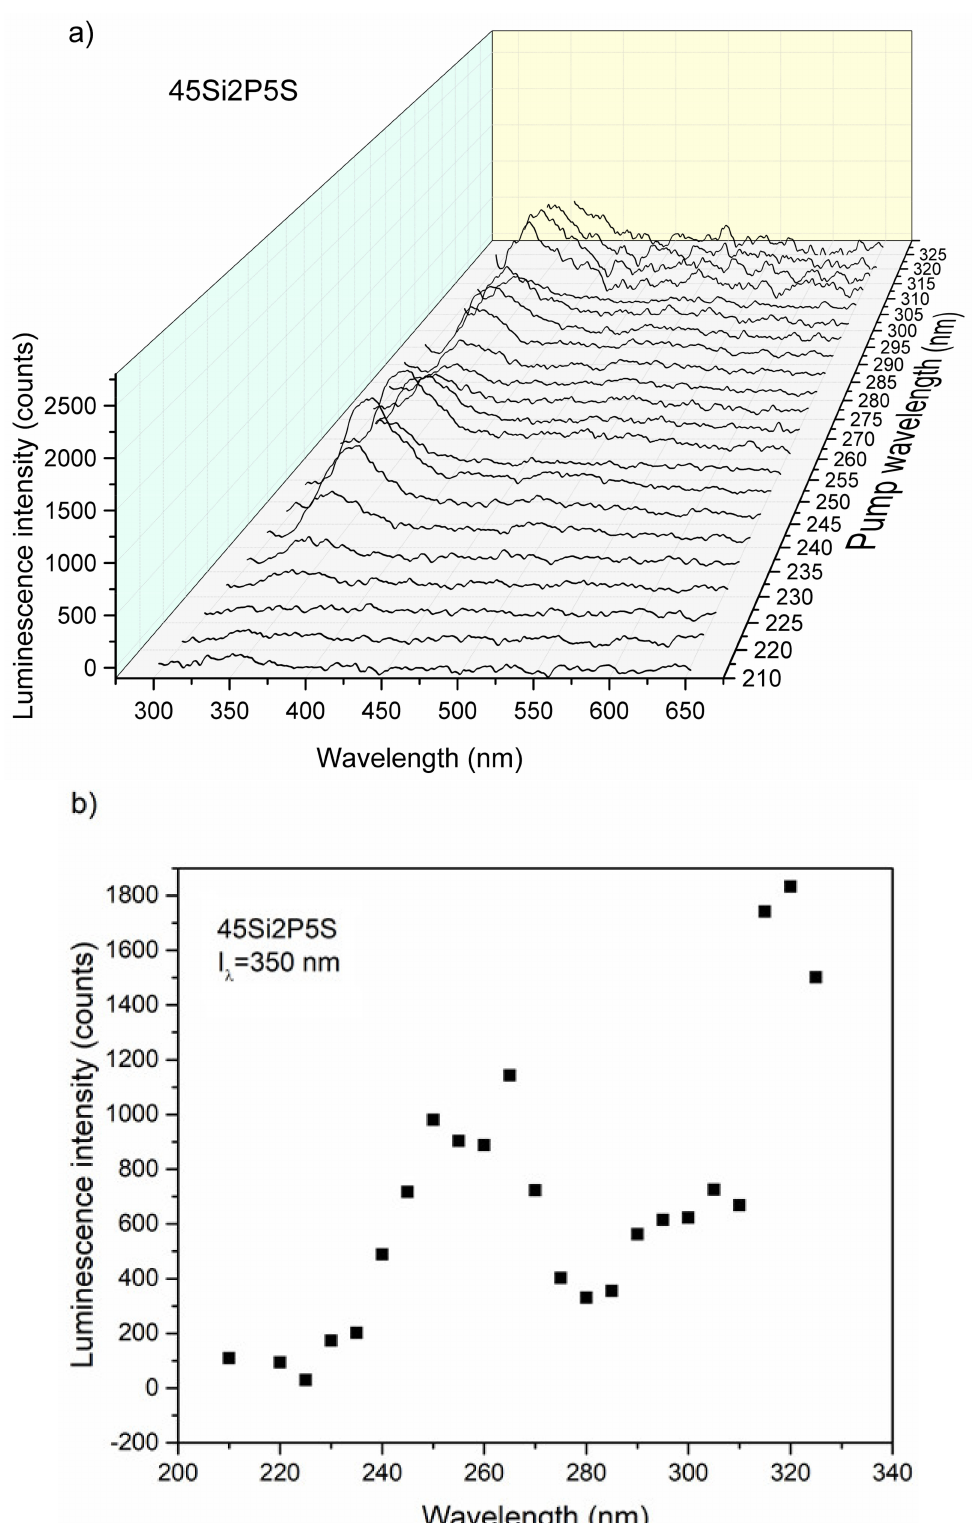
Figure 17. Luminescence intensity vs. wavelength and the laser pump ( a ) and luminescence intensity vs. wavelength at 500 nm ( b ) for the 45Si2P5S